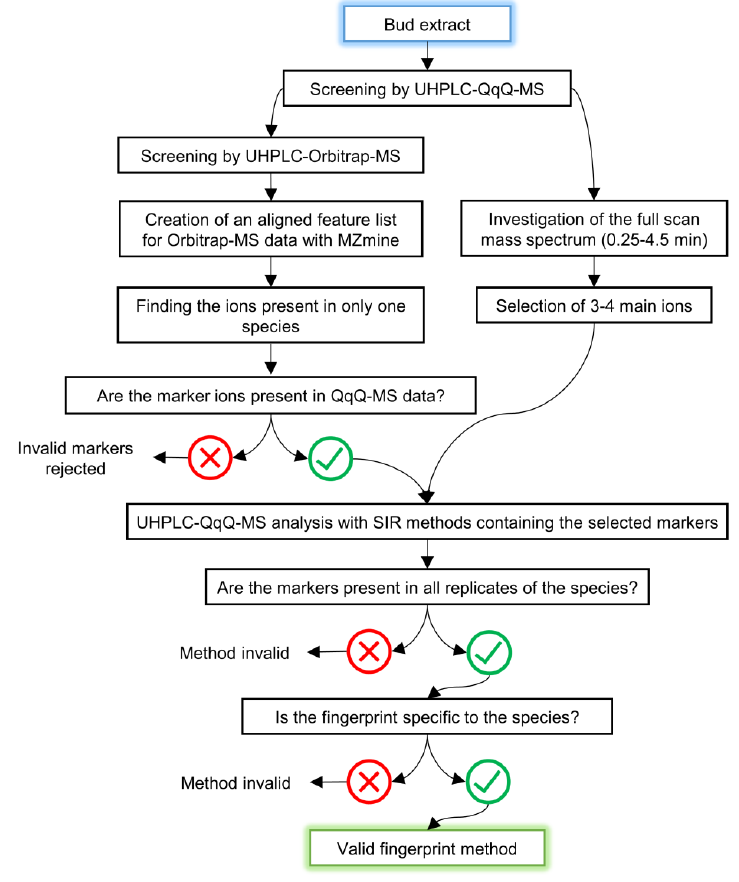
Figure 1. Flow chart of the method development of two different methods. 2.1.1. Method I: Species-Specific Markers from the High-Resolution MS Data Obtained with MZmine 2